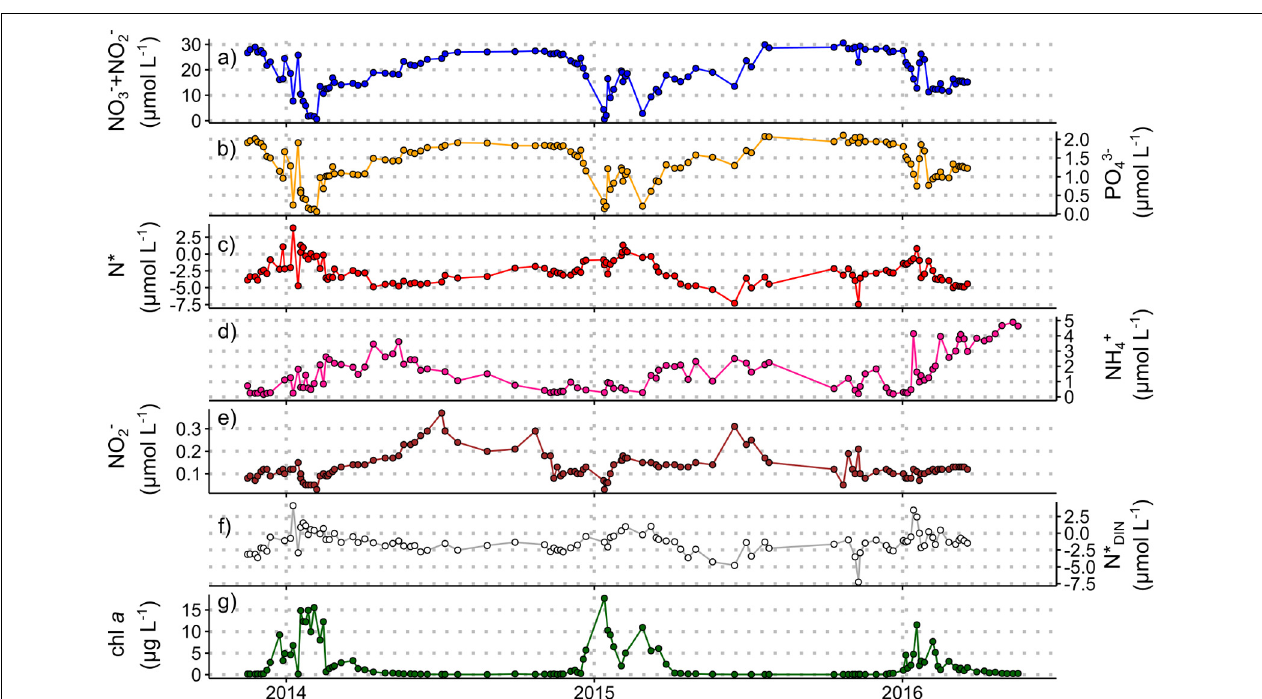
FIGURE 3 | Nutrient concentration and stoichiometry data from the Rothera Time Series, November 2013 to March 2016 (see Supplementary Information 2 for details). Measured concentrations for samples taken at 15 m water depth of (a) nitrate + nitrite, (b) phosphate, (c) N*, (d) ammonium, (e) nitrite, and (f) N* DIN . Chlorophyll a concentrations (g) are included to indicate the timing and magnitude of summer phytoplankton blooms. Chlorophyll data courtesy of the British Antarctic Survey. These data are available through the British Oceanographic Data Centre (BODC) at https://www.bodc.ac.uk/data/published_data_library/catalogue/ 10.5285/98cc0722-e337-029c-e053-6c86abc02029/ (Henley and Venables,